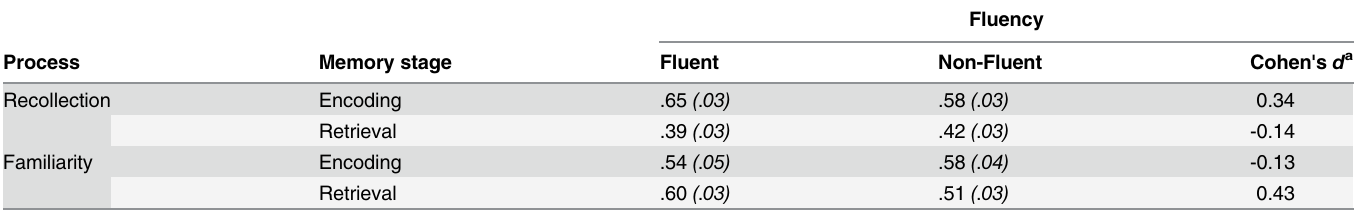
Table 1. Experiment 1. Mean estimates (and SE) of Recollection and Familiarity hit rates, as a function of Fluency (Fluent, Non-fluent) and Memory stage (Encoding,